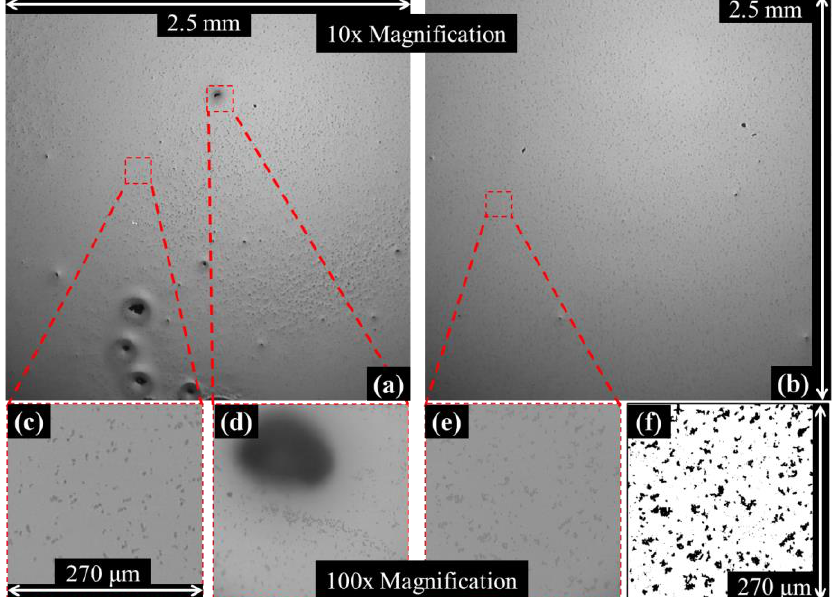
Figure 5. Microscopy of two separately prepared nanocomposite film samples at varying magnifi- cations. ( a , c , d ) Sample probed with 2 kJ of energy, imaged at ( a ) 10 × magnification and ( c , d ) 100 × magnification. ( b , e , f ) Sample probed with 17 kJ of energy, imaged at ( b ) 10 × magnification and (e, f ) 100 magnification.